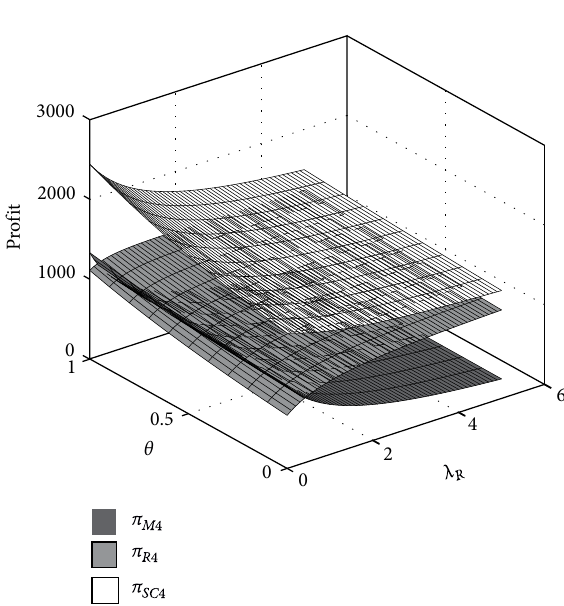
Figure 8: The effect of 𝜃 , 𝜆